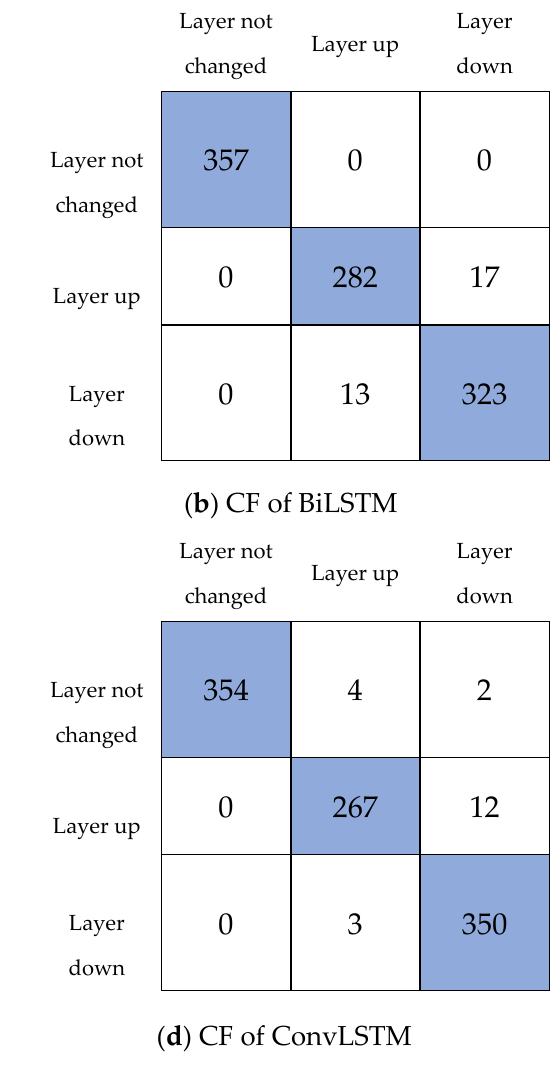
Figure 9. Confusion matrices of LSTMs